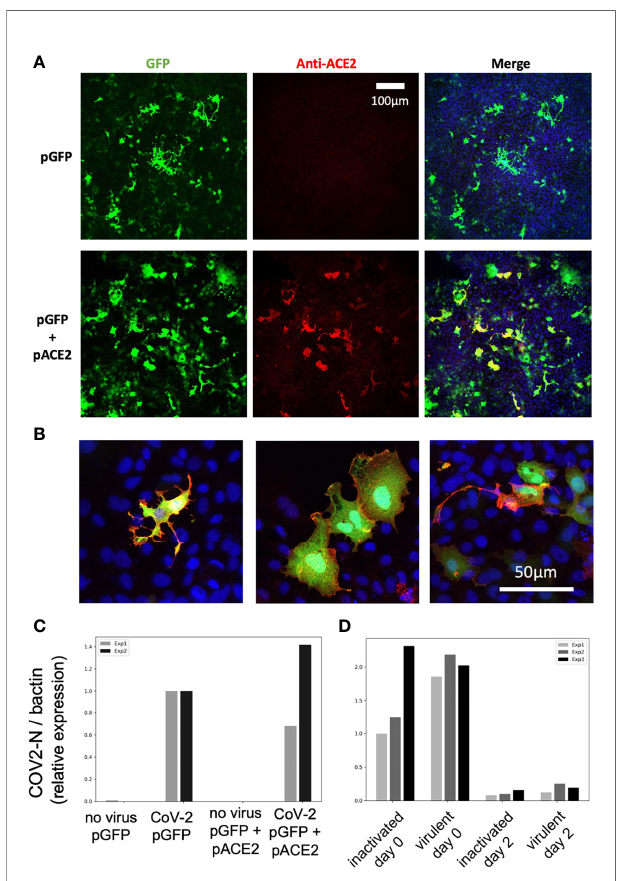
FIGURE 11 | SARS-CoV-2 does not replicate on EPC cells transfected with human ACE2. (A, B) Confocal microscopic images of EPC cells cultures 3 days after transfection. (A) Assessment of transfection ef fi ciency at low magni fi cation. (B) Demonstration of hACE2 expression at the membrane of cells transfected with both plasmids, high magni fi cation, merge images of GFP, hACE2, and nuclei labels. (C, D) qRT-PCR measurement of N copies in cells. (C) Measurement at 2 days postexposure with virulent SARS-CoV-2, comparison of GFP and GFP+hACE2 overexpression. (D) Decline of RNA levels from day 0 to day 2 postexposure, and comparison of heat-inactivated and virulent